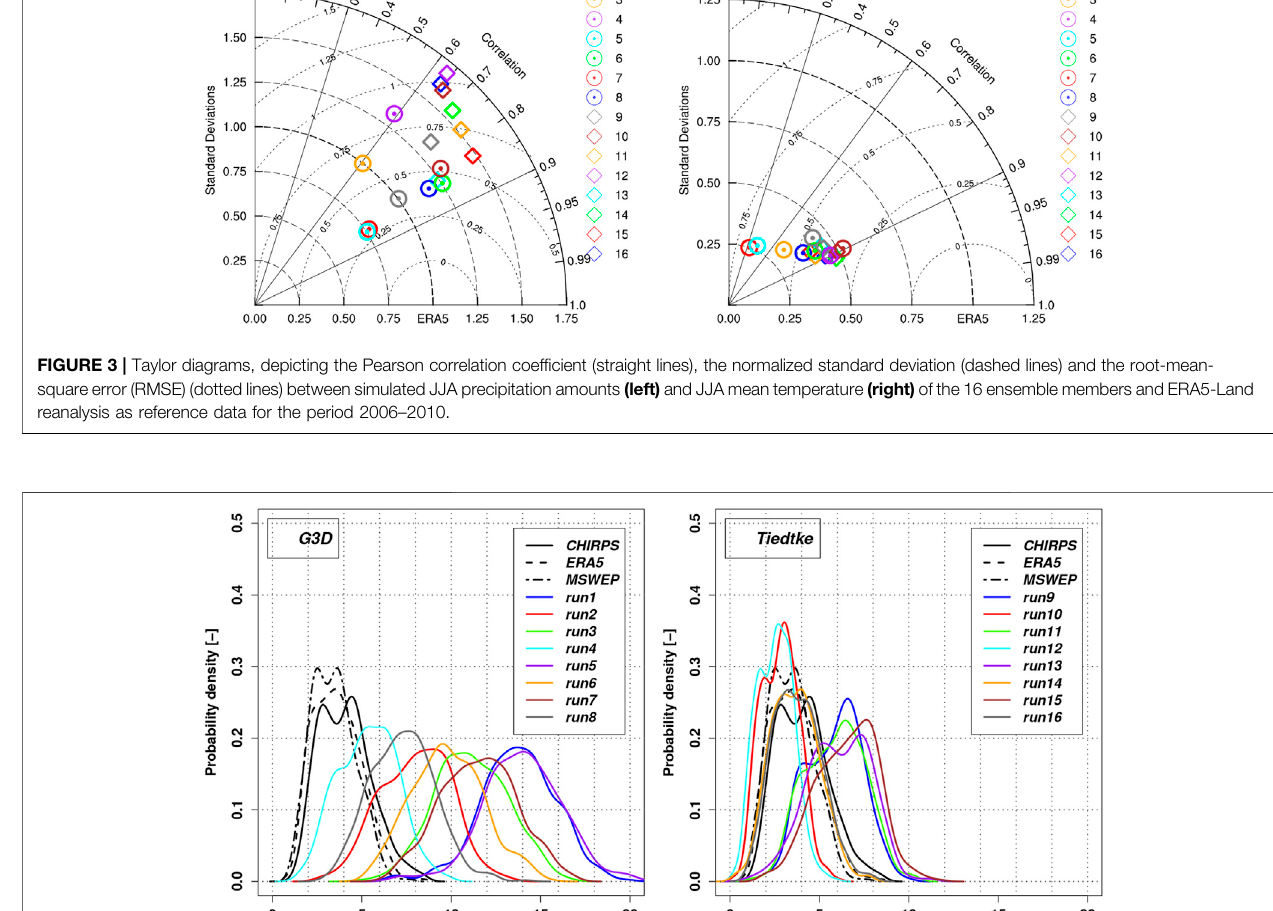
Frontiers in Earth Science |